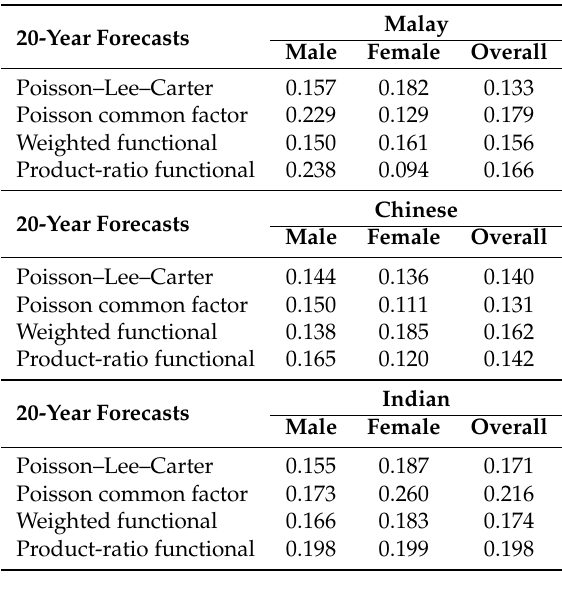
Table 9. Mean Absolute Forecast Errors ( MAFE ) according to ethnic groups and gender in Malaysia. Gender-coherence is imposed on coherent models for Malay, Chinese and